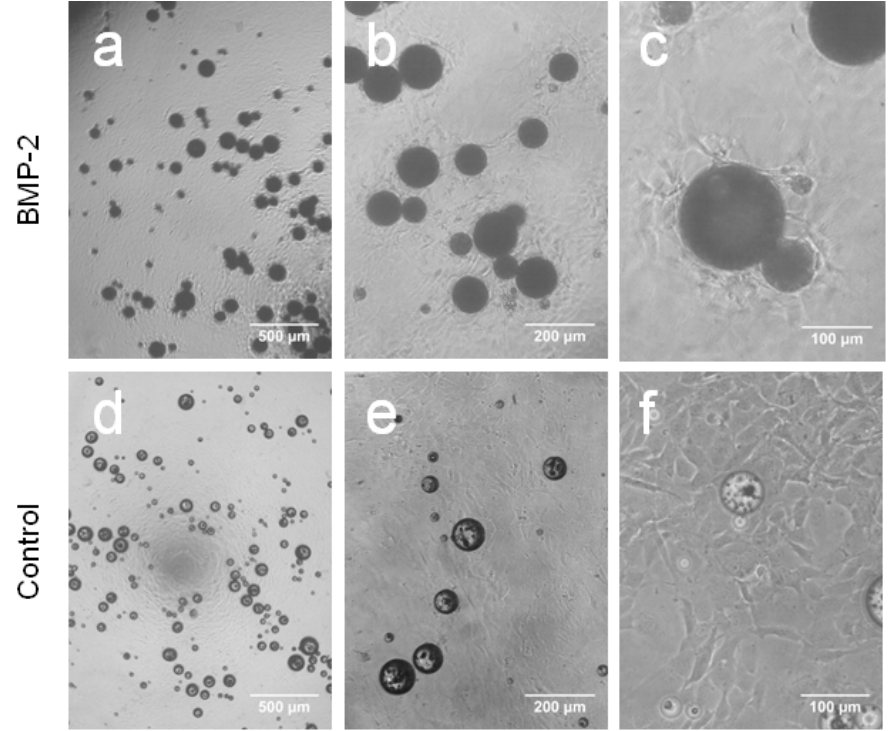
Figure 4. Optical microscopy images show the behaviour of the cells after six days in culture with BMP-2 loaded PLGA composite microparticles and control PLGA microparticles containing no BMP-2. The preferential attachment of cells to the BMP-2 loaded microparticles can be seen under three different magnifications; 4× ( a , d ), 10× ( b , e ) and 20× ( c , f ). The cells attached to the BMP loaded particles are in a different focal plane to those attached to the tissue culture plastic giving the appearance of poor cell attachment (c) but cell attachment was in fact consistent between